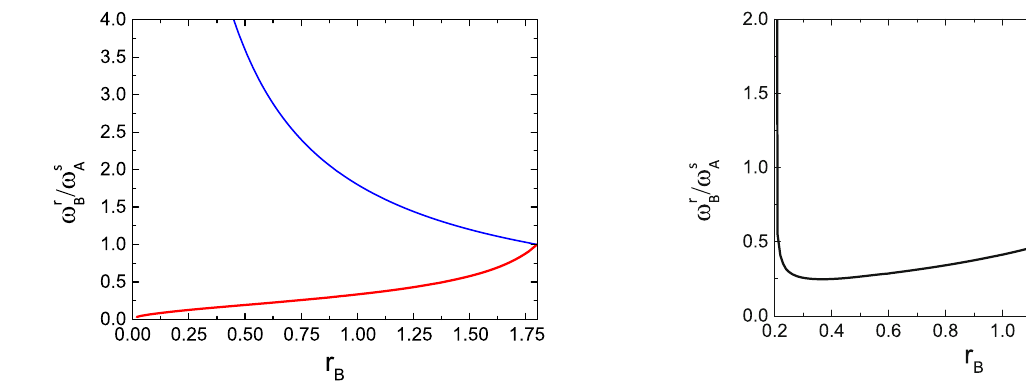
Fig. 8 Frequency shift inside horizon of RN BH ( M = 1, Q = 0 . 6), for signals propagating along the t -axis r − = 0 . 2 < r B < r A = 1 . 6: initial redshift Eq. (55) is followed by the final blueshift Eq. (56) (due to expansion followed by